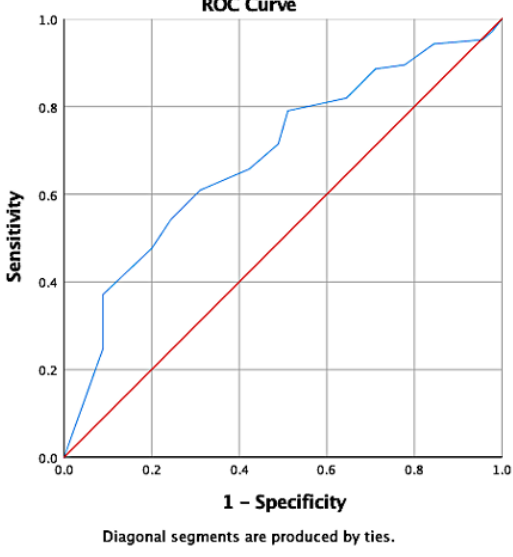
Figure 1. ROCs of TCQ scores determined by cognitive dysfunction in Group 2. Table 4. Coordinates of the Curve of TCQ * total score with cognitive dysfunction in Group 2.